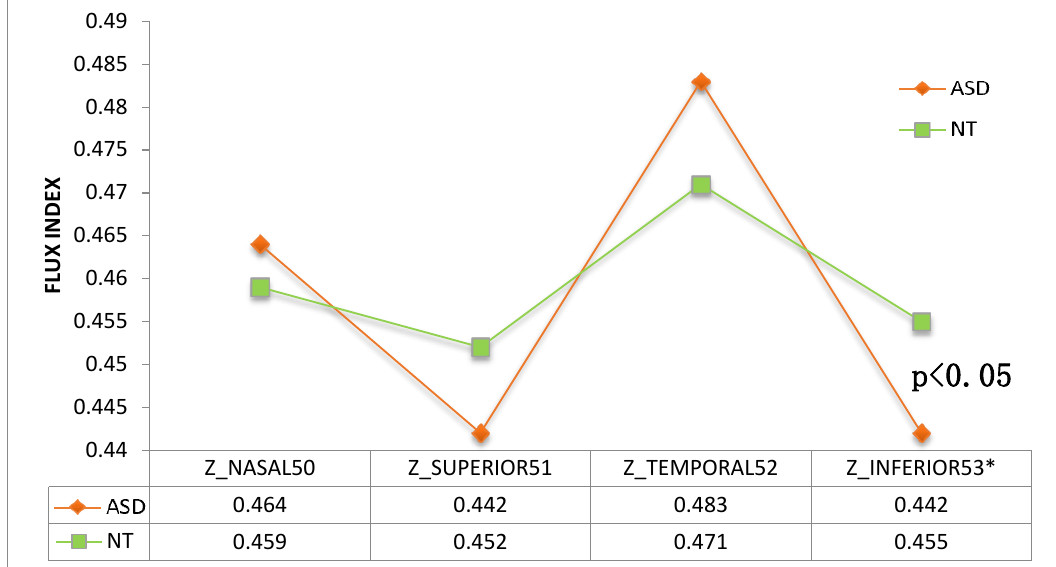
Figure 12. Flux index of the 4 peripapillary quadrants. ASD = autism spectrum disorder group; NT = neurotypical group. Mean values were indicated for each group. * Note that the difference between inferior values is statistically significant ( p = 0.037, Mann–Whitney U test).